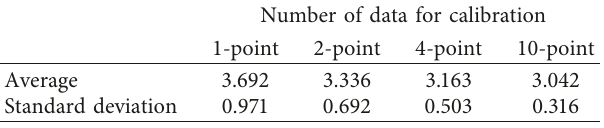
Table 2: Accuracy of the estimation equation according to the number of correction data.